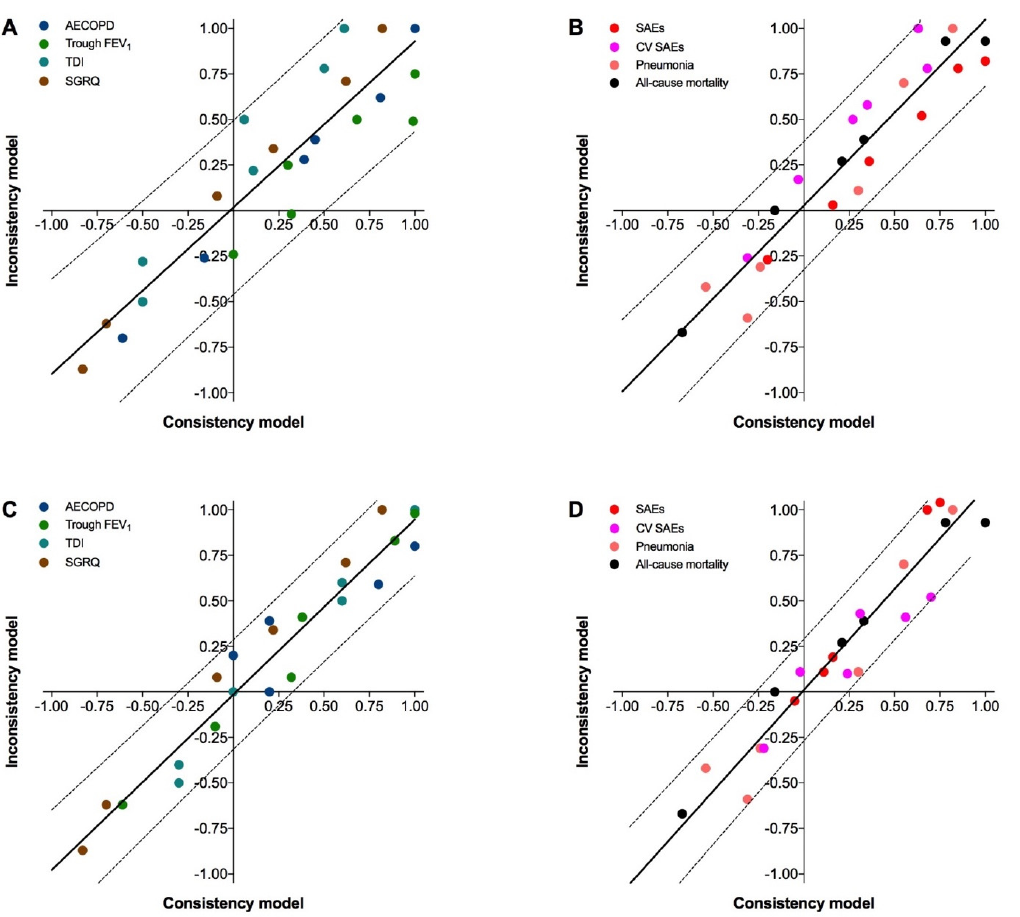
Figure 4. Assessment of the risk of bias via the consistency/inconsistency regression with 95% prediction bands concerning the efficacy ( A ) and safety ( B ) outcomes and after sensitivity analysis ( C , D ) by excluding the treatment comparisons introducing inconsistency in the Bayesian network.